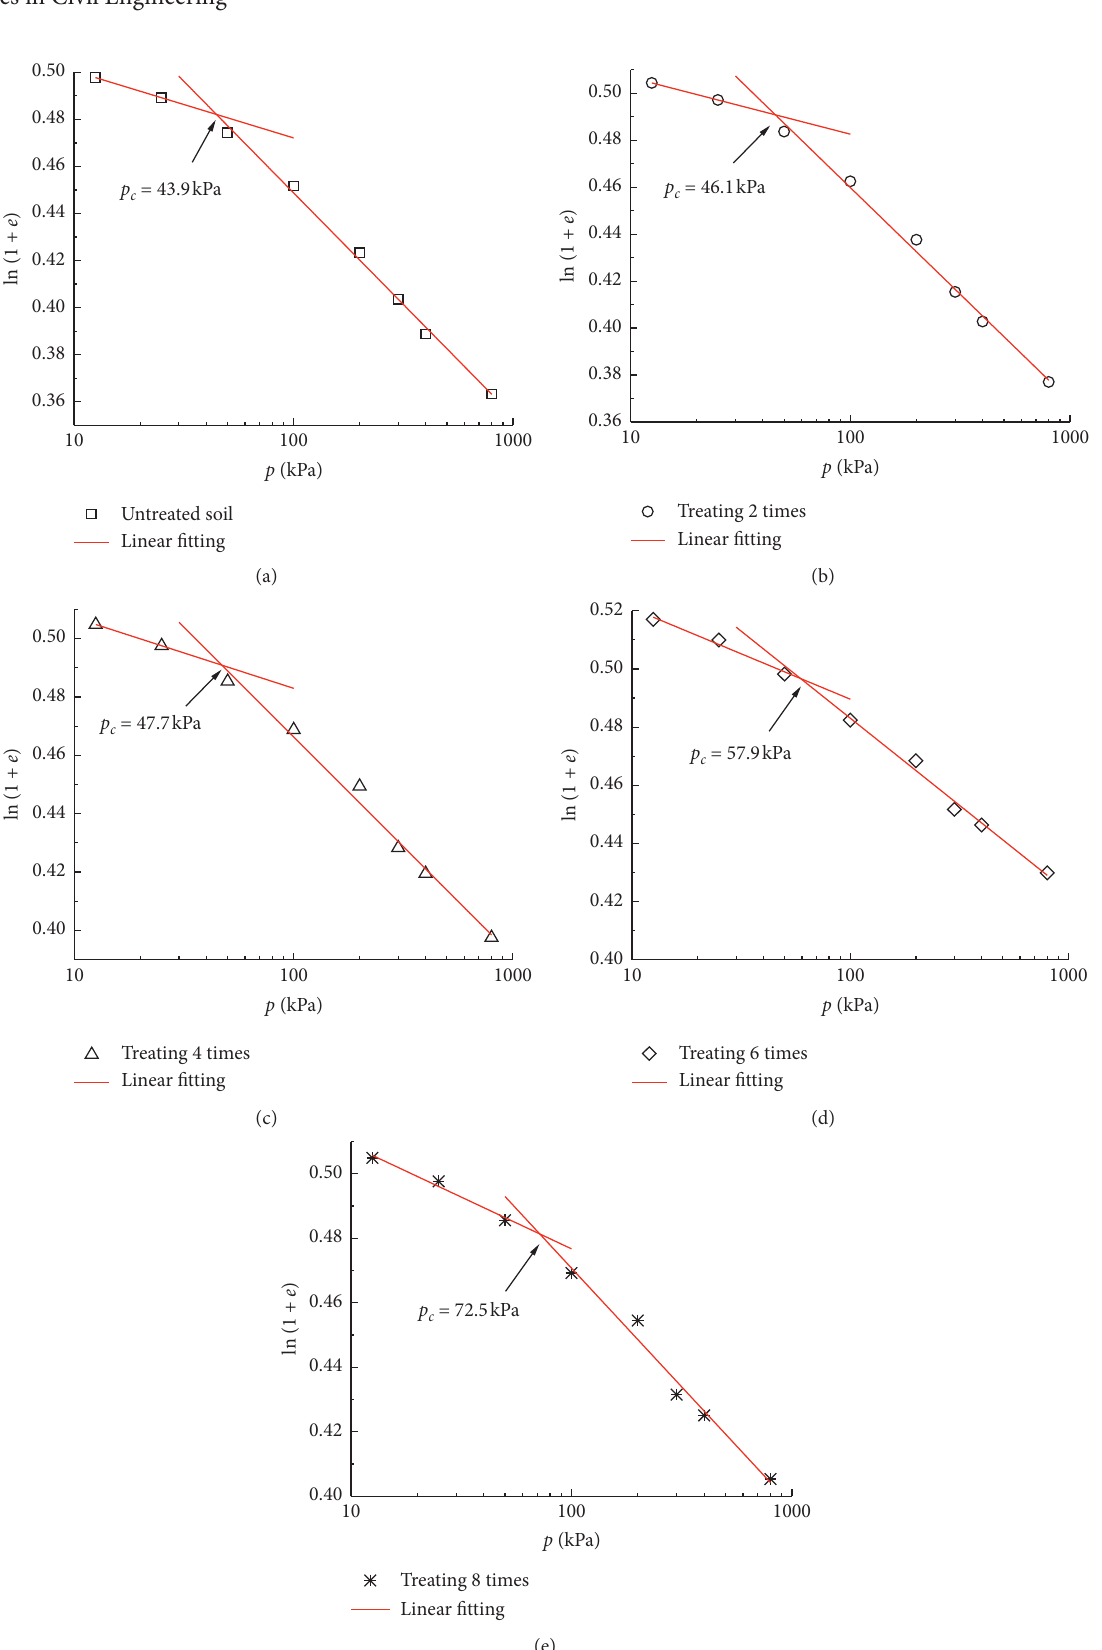
Figure 6: compression curve (ln (1+e) - lgp) of microbially-treated expansive soil